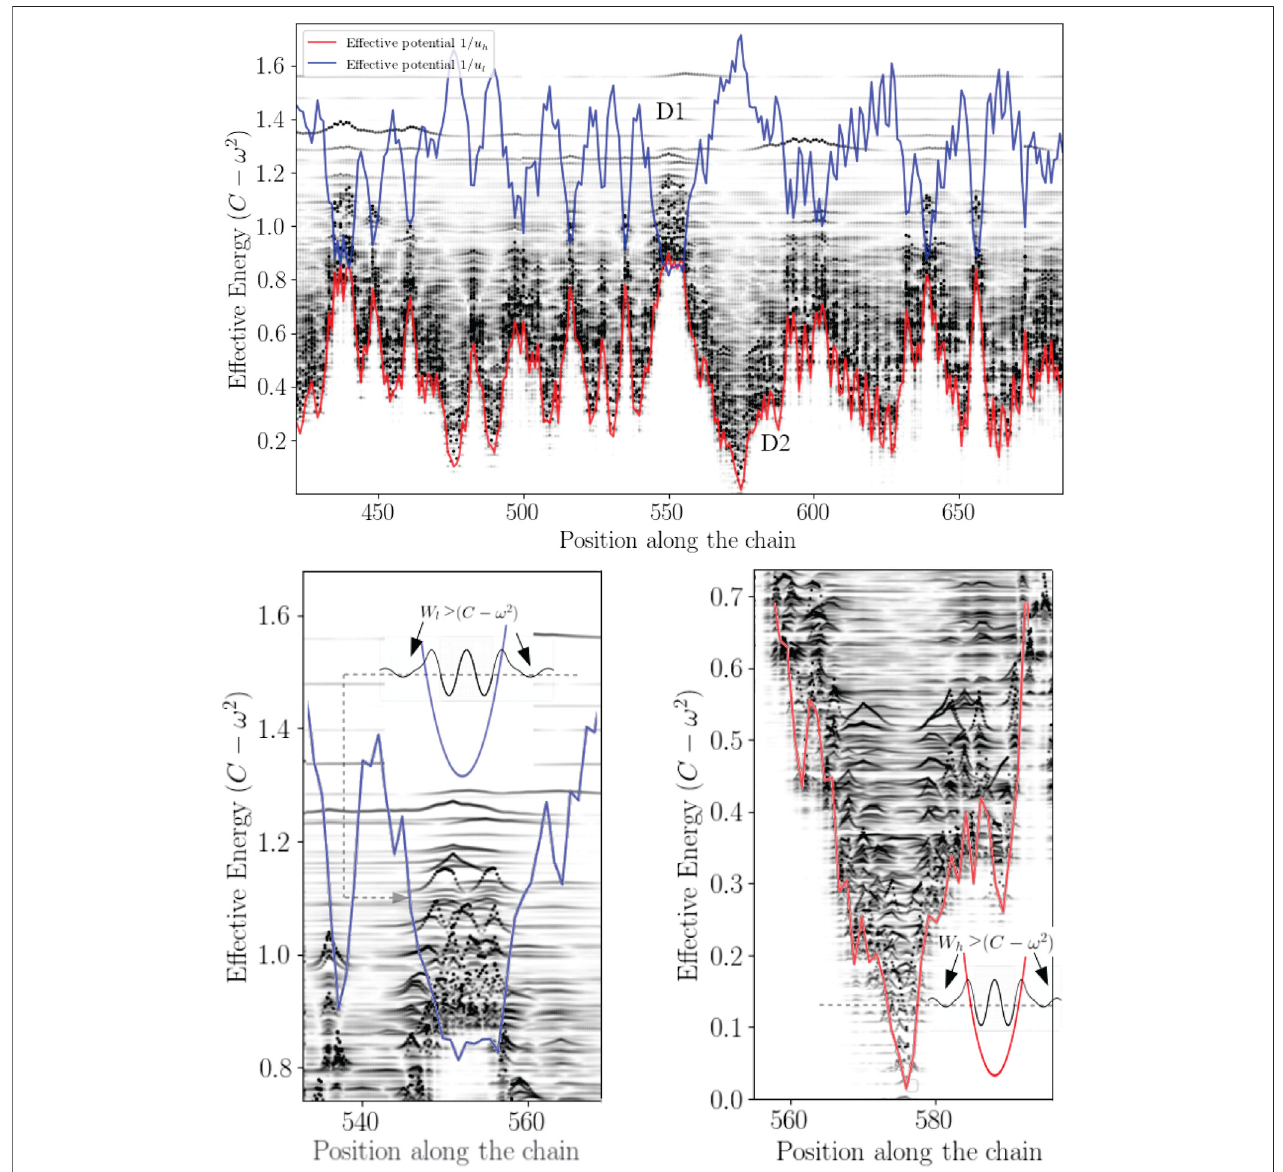
FIGURE 4 | Bilocalization effect The modulus of the normal modes are plotted and shifted according to their eigenvalues by C − ω 2 (dark points). The con fi nement potentials corresponding to high (red) and low frequency modes (blue) are spatially complementary. The modal amplitude decays exponentially inside the potential.